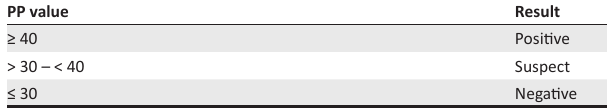
TABLE 2: Cut-off value ranges for the double-antigen ELISA.